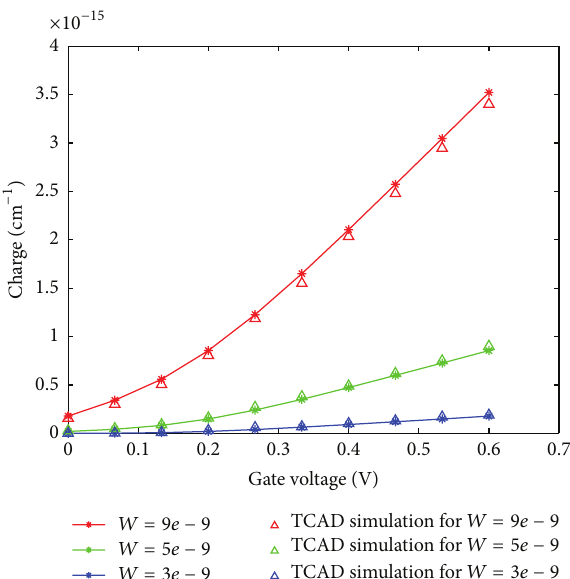
Figure 4: Variation of quantum integrated charge at virtual source with gate voltage for different film widths where the height and length are 𝐻 = 9 nm, 𝐿 = 20 nm.